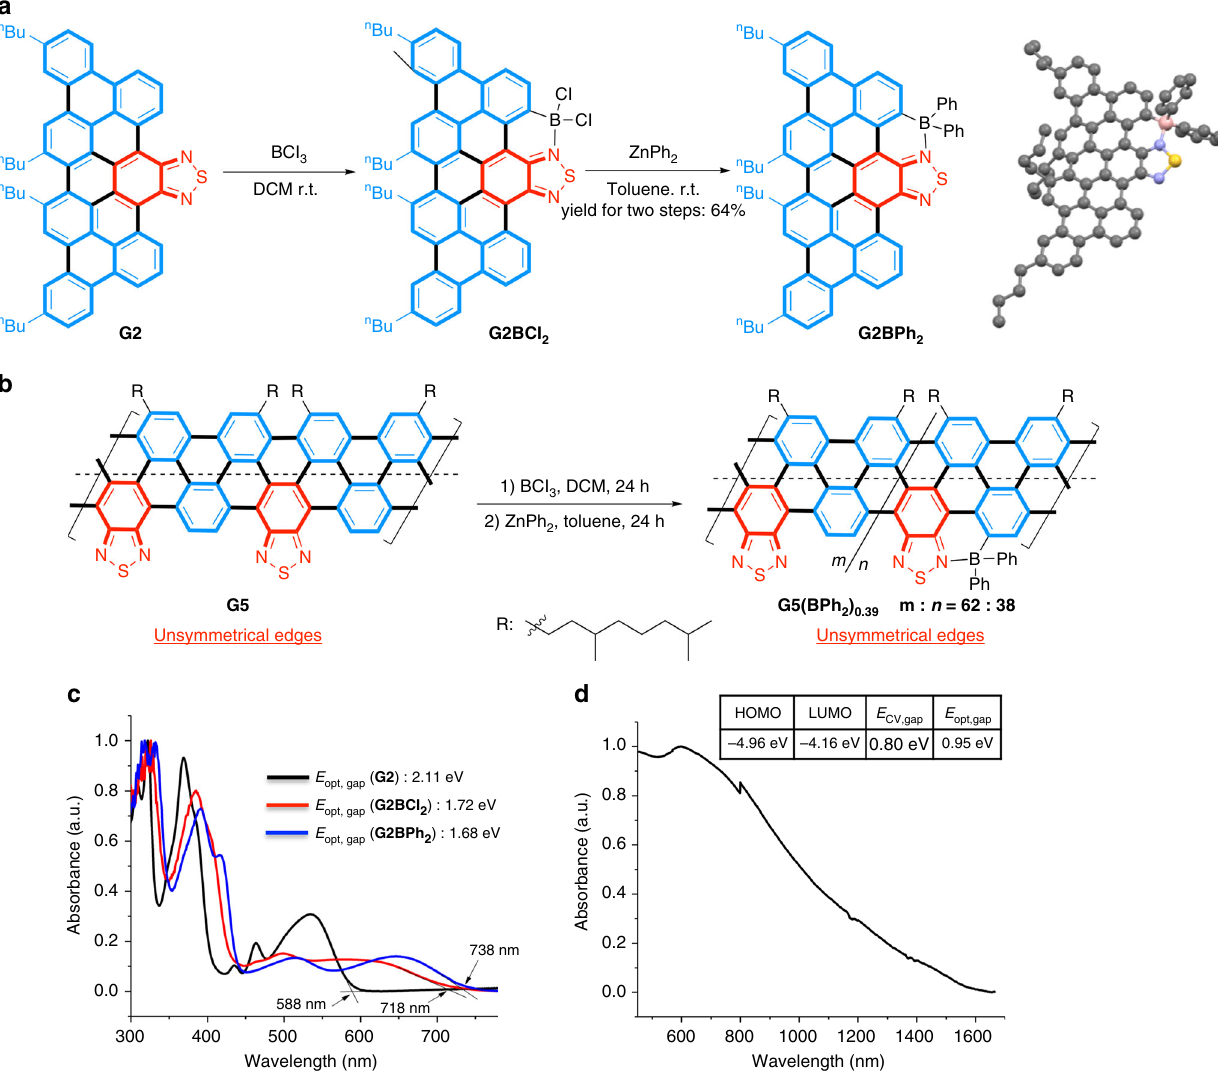
Fig. 6 Post-functionalization through unsymmetrical heterocyclic edges. a C – H borylation of G2 (and its crystal structure) and. b C – H borylation of G5 . c UV – vis spectra of G2 , G2BCl 2 , and G2BPh 2 in THF. d UV – vis – NIR spectrum of G5(BPh 2 ) 0.38 in THF suspension and HOMO/LUMO levels obtained by cyclic voltammogram of G5(BPh 2 ) 0.38 (inset